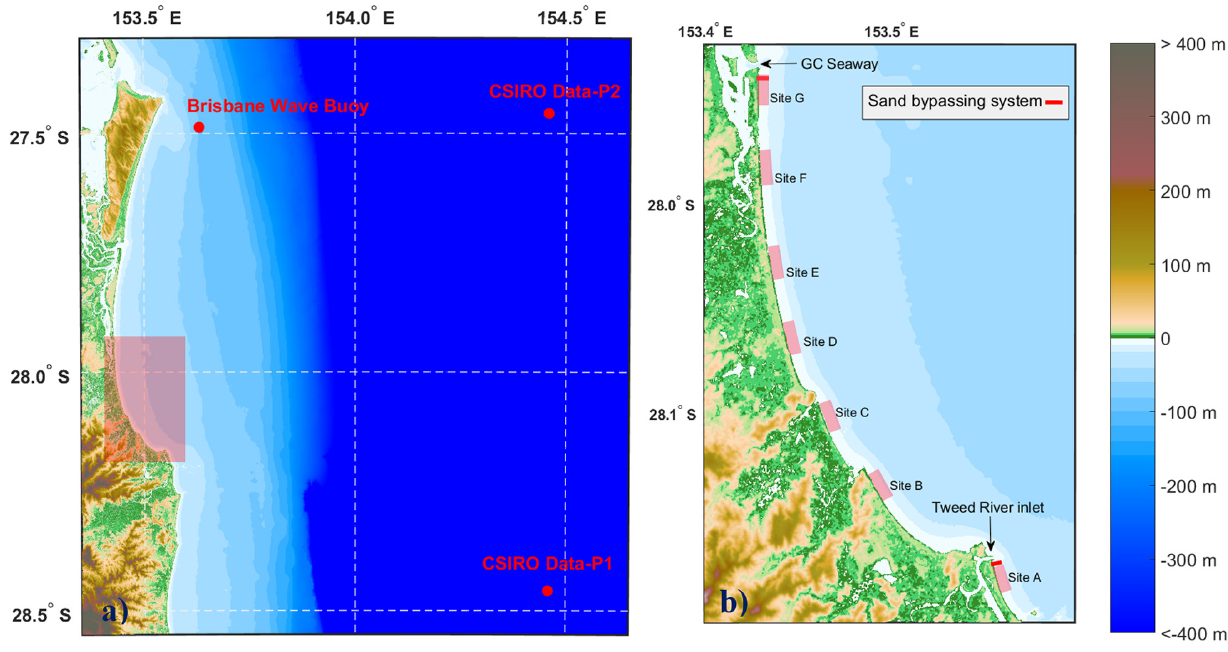
Frontiers in Marine Science |